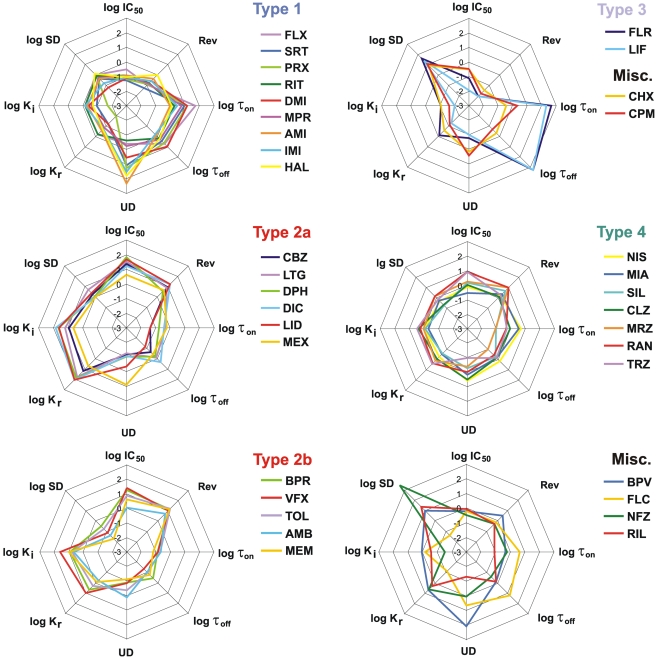
Properties of inhibition illustrated on radar diagrams.Different panels show different types of inhibition. ‘Type 2’ drugs were divided into two panels (based on the results of cluster analysis) for the sake of visibility. For individual values of properties see Table 2 and Table 3.